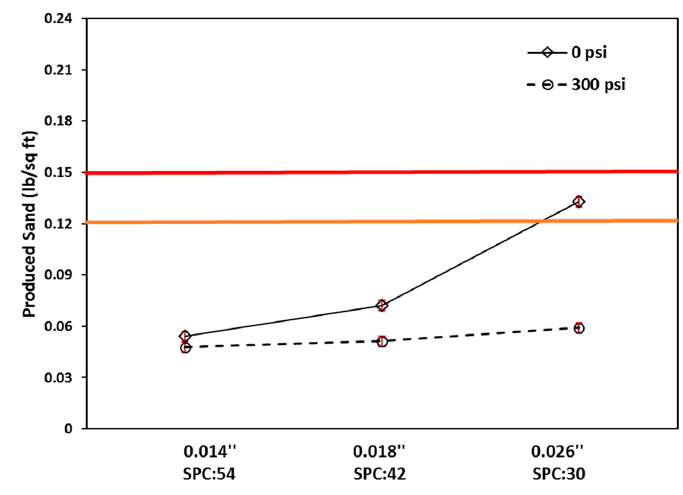
Figure 13. Effect of slot size and density on cumulative sand production; solid lines are the upper limit of acceptable produced sand of 0.12 lb/sq ft (0.58 kg/m 2 ) and 0.15 lb/sq ft (0.73 kg/m 2 ).